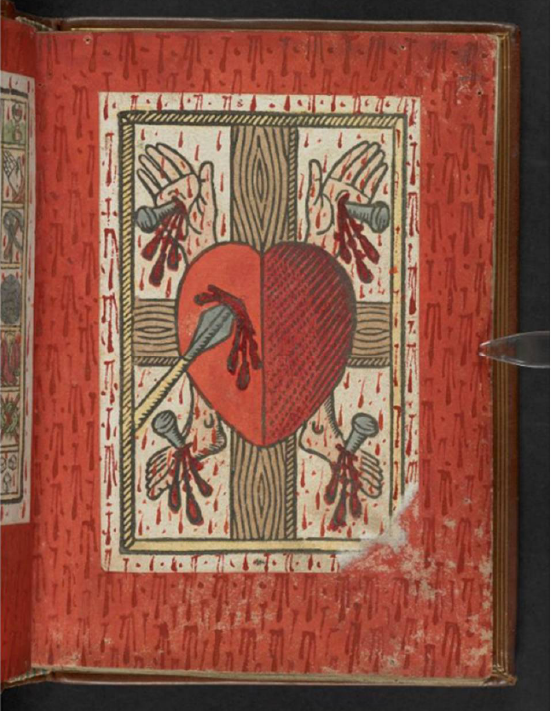
Figure 4. The five wounds of Christ were major devotional foci in late medieval devotion. The frame of the woodcut has small wounds painted into it. MS Egerton 1821, fol. 9r. British Library, London.